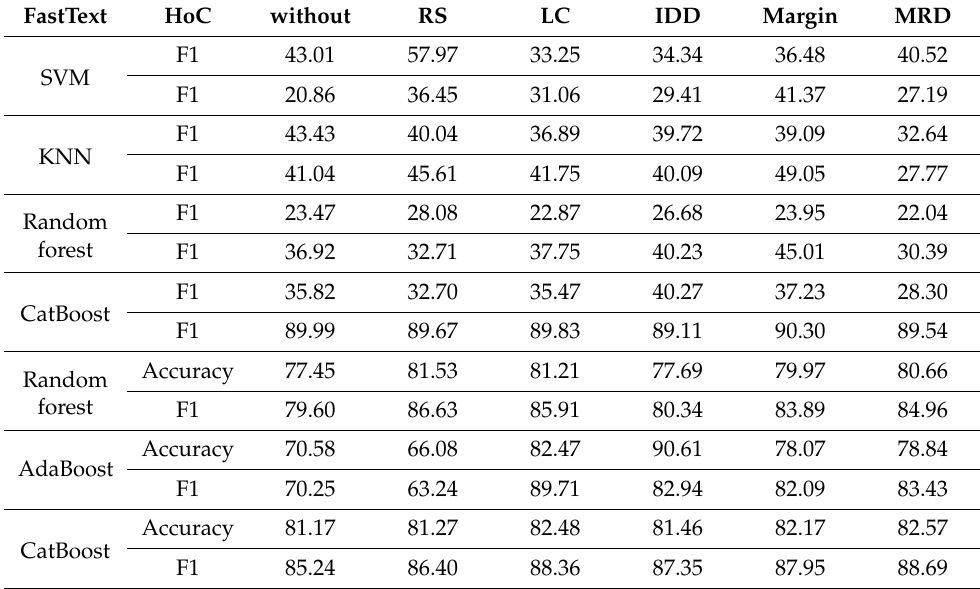
Table 6. Comparison of results with and without AL methods (FastText) for HoC dataset.